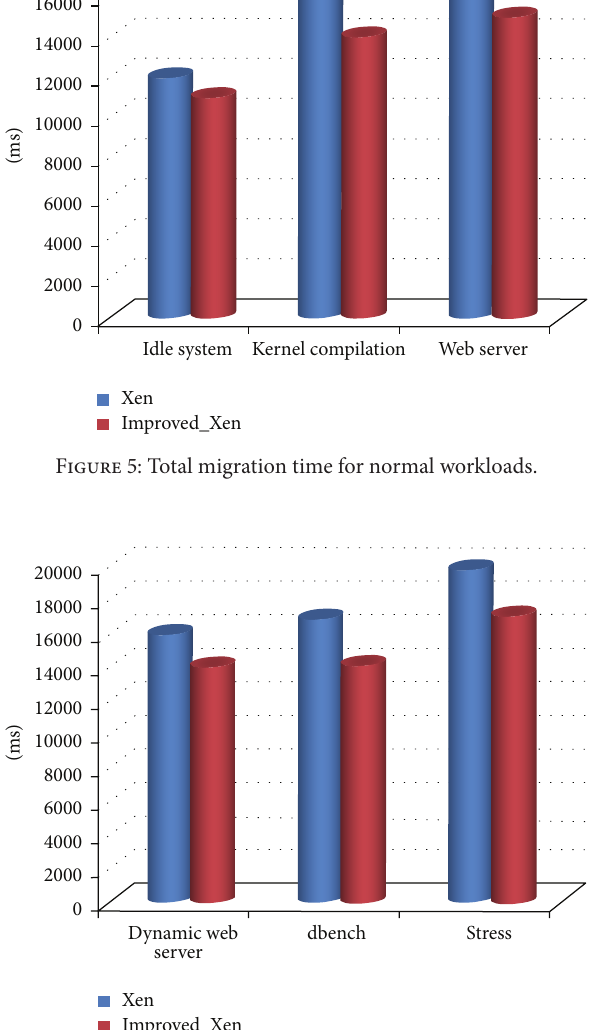
Figure 6: Total migration time for advanced